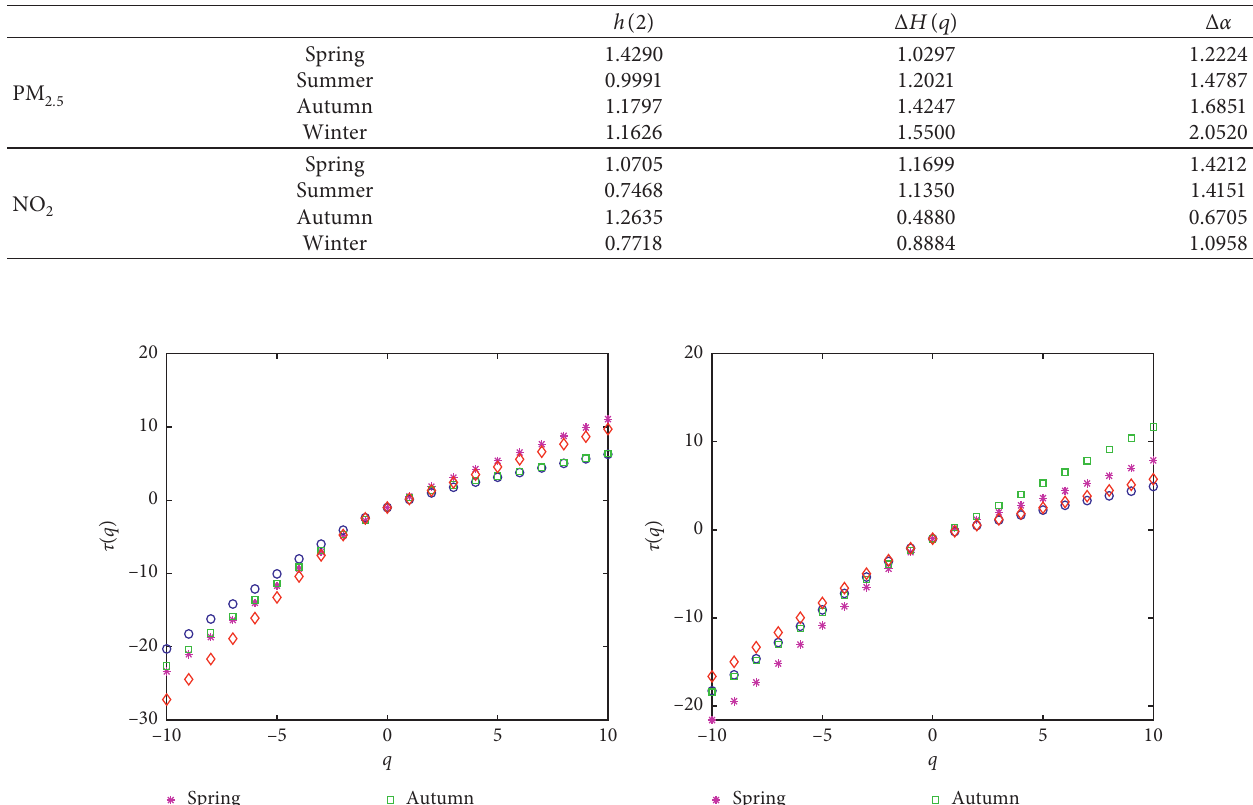
concentration and (b) NO concentration. 2 . 5 2 and NO concentrations. 2 . 5 2